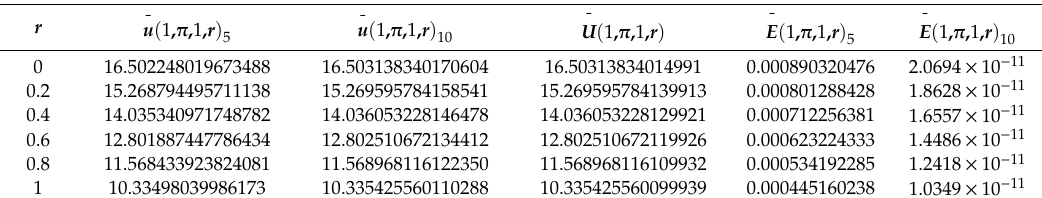
Table 12. Solution and accuracy of fifth and tenth order double parametric fuzzy HPM solutions for Equation (32) at t = π , x = 1 and b = 1 for all r ∈ [ 0,1 ] .